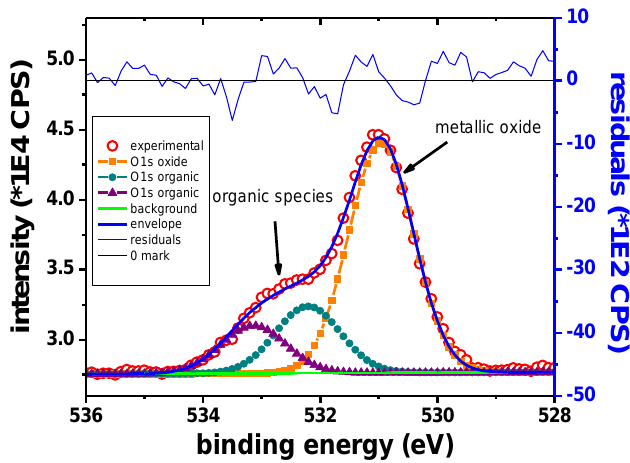
Figure 12. O1s narrow scan, Zn sample.